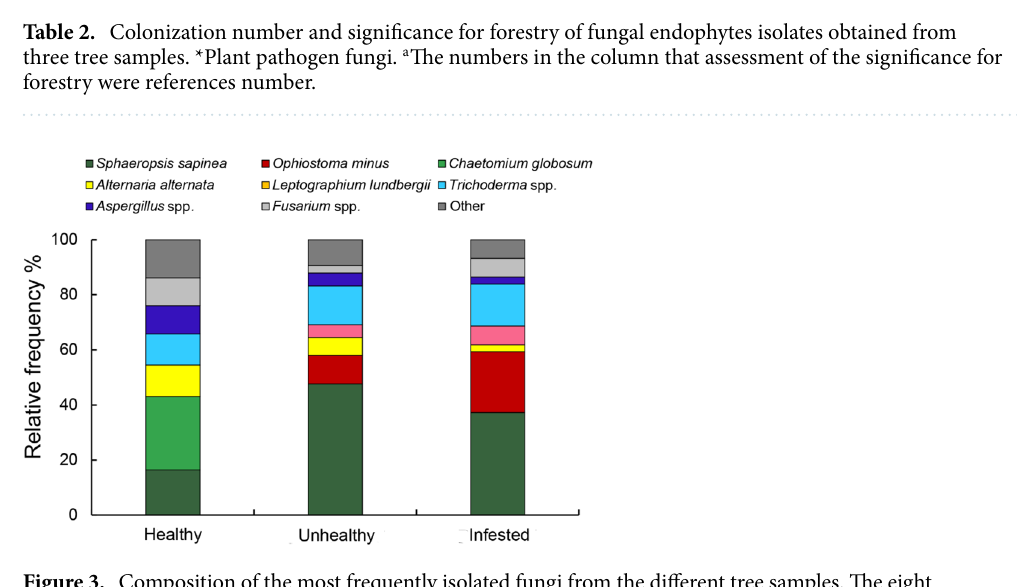
Figure 3. Composition of the most frequently isolated fungi from the different tree samples. The eight most frequently cultivated species (genera) were selected and the prevalence (%) of each species (genus) was determined per tree samples.